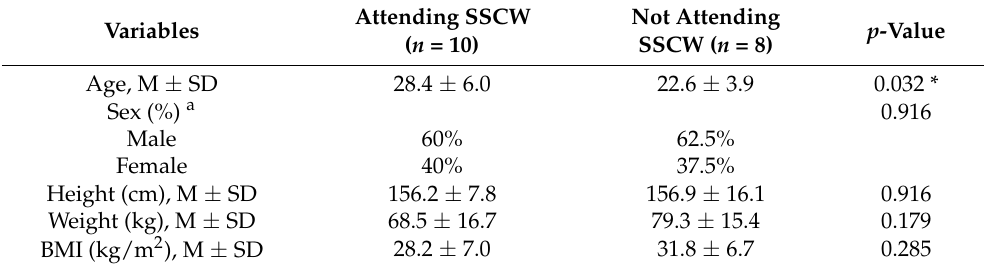
Table 1. Characteristic of participants.